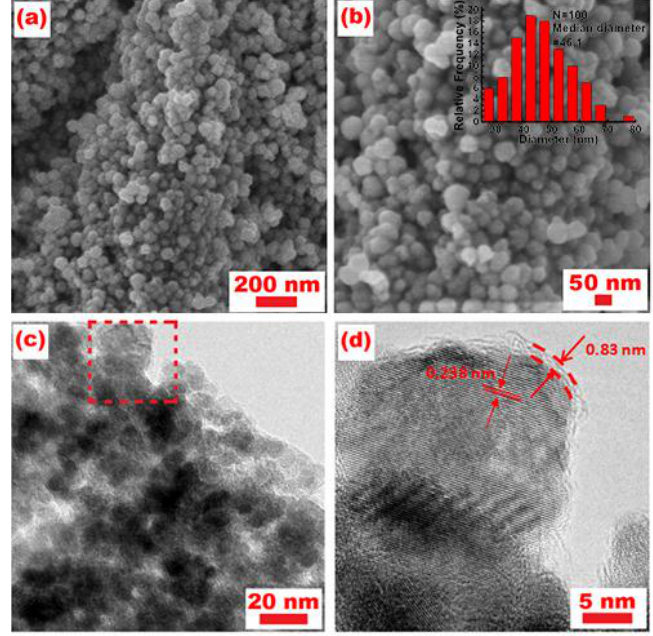
Figure 3. SEM images ( a , b ) and corresponding median diameter (inset) and TEM images ( c , d ) of the